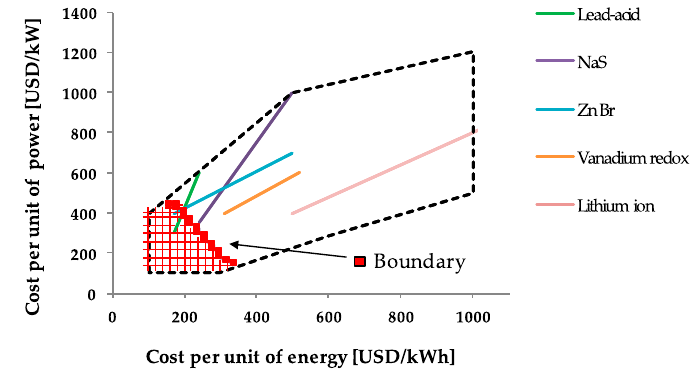
Figure 3. Break even costs for the SB.